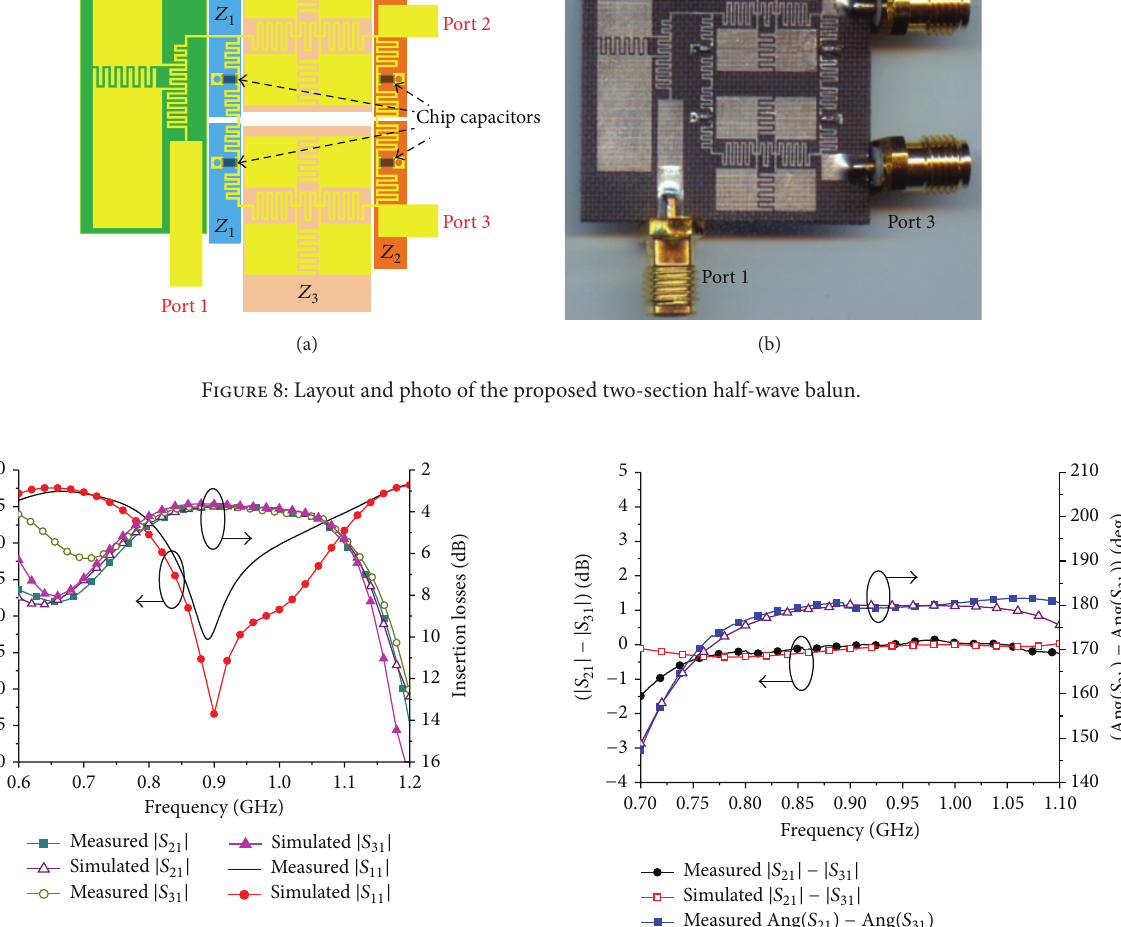
Figure 9: Measured and simulated return losses and insertion losses.